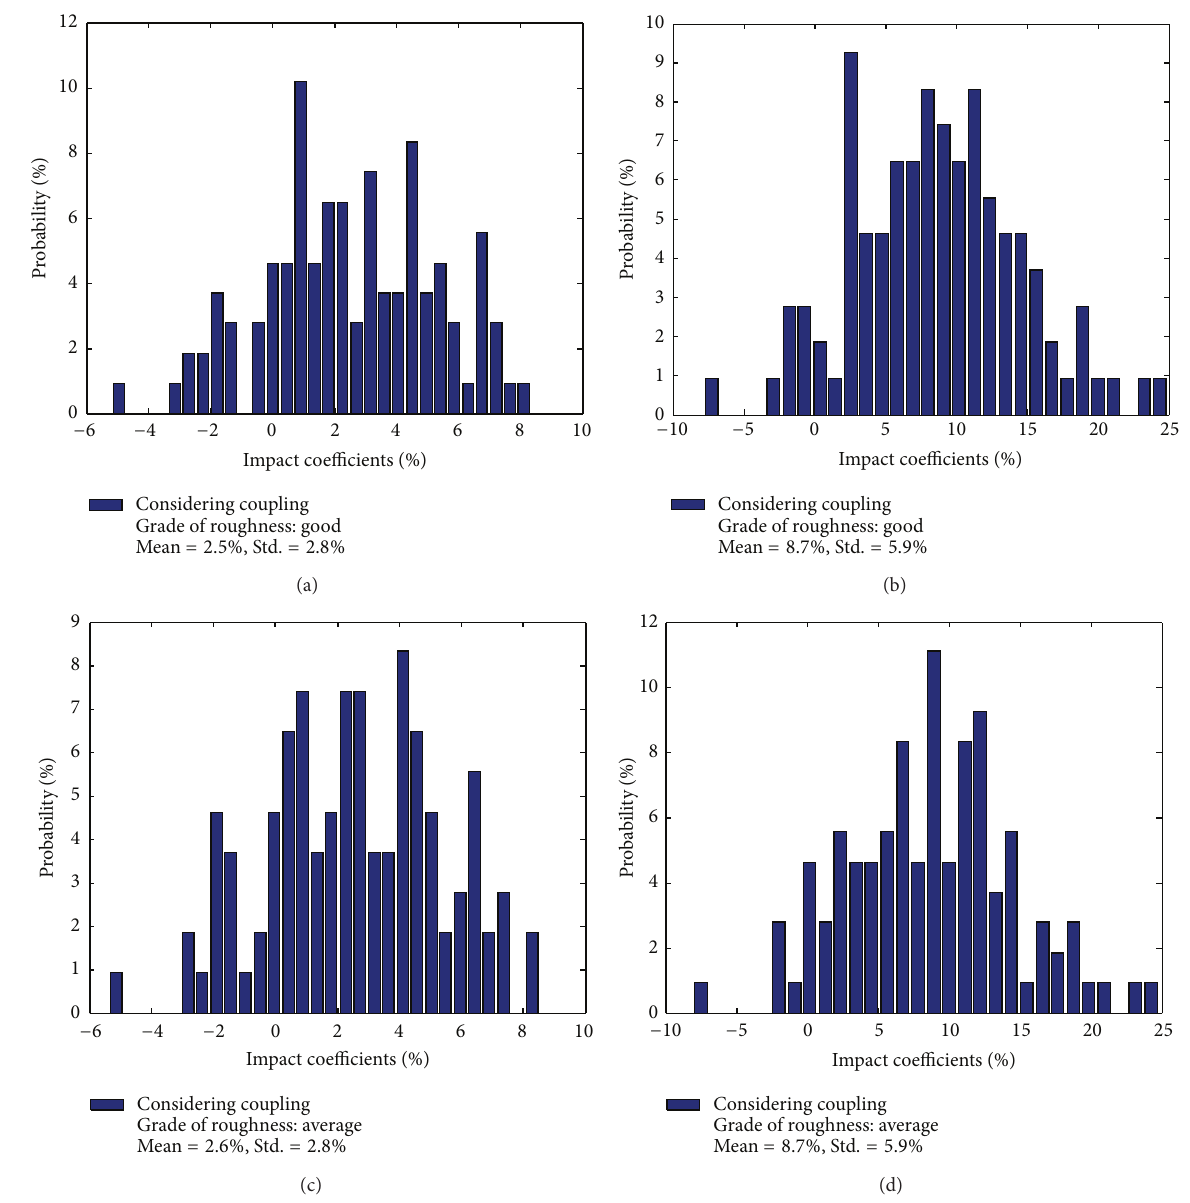
Figure 19: Probabilistic distributions of vertical displacement impact coefficients at point C of the bridge in a windy environment: at the mean wind velocity of (a) 30 m/s; (b) 49.8 m/s; (c) 30 m/s; (d) 49.8